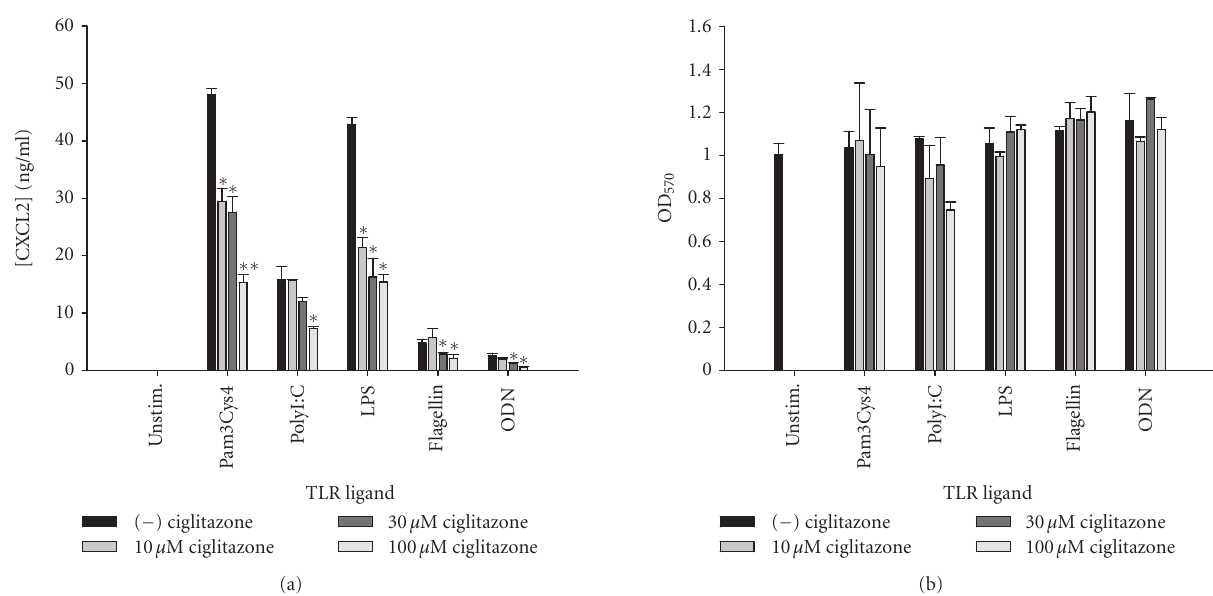
Figure 13: Ciglitazone attenuates astrocytic CXCL2 expression in response to several TLR ligands. Primary astrocytes were plated at 1 × 10 5 cells/well in 96-well plates and incubated overnight. The following day, cells were pretreated for 1 hour with the indicated concentrations of ciglitazone prior to the addition of TLR ligands. Cell-conditioned supernatants were collected at 24hours following TLR ligand exposure, whereupon CXCL2 levels were determined by ELISA (a). The e ff ects of ciglitazone on astrocyte viability were assessed using an MTT assay (b). Significant di ff erences between astrocytes treated with TLR ligands alone versus TLR ligands + ciglitazone are noted with asterisks ( ∗ P < . 05; ∗∗ P < . 001). Results presented are representative of two independent experiments.